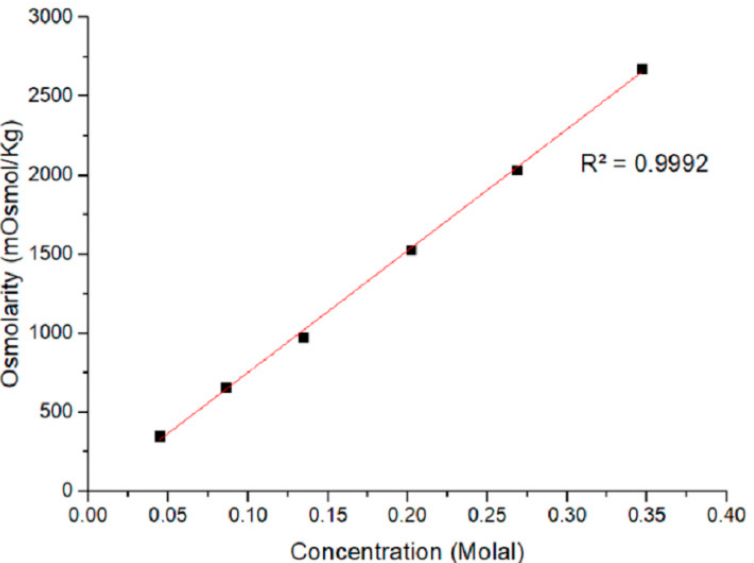
Figure 5. Osmolarity measurements with the ionosilica hydrogel dispersions at various concentrations.